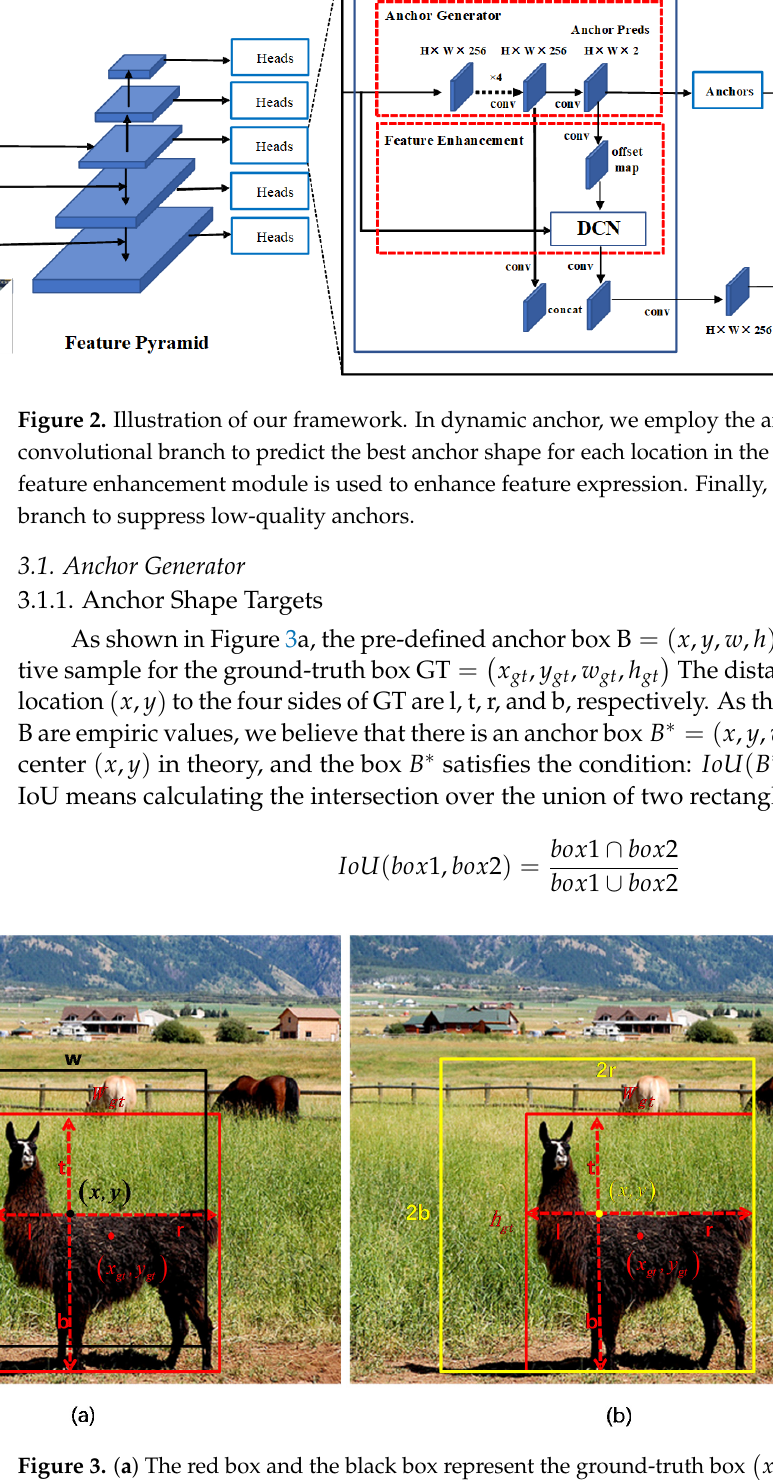
(cid:0) (cid:1) x gt , y gt , w gt , h gt and the